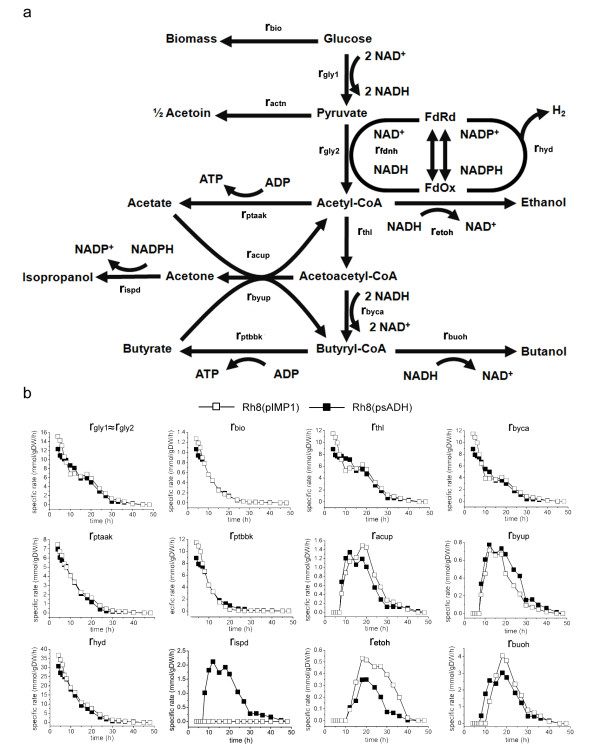
GC-MS analysis the acetone in culture broth of C.
acetobutylium Rh8(pIMP1) and C.
acetobutylicum Rh8(psADH). (a) The
standard retention time of acetone was about at 2.0 min.
(b) Detection of acetone in the culture broth of C.
acetobutylicum Rh8(pIMP1). (c) Detection of residual
acetone in the culture broth of C. acetobutylicum
Rh8(psADH).